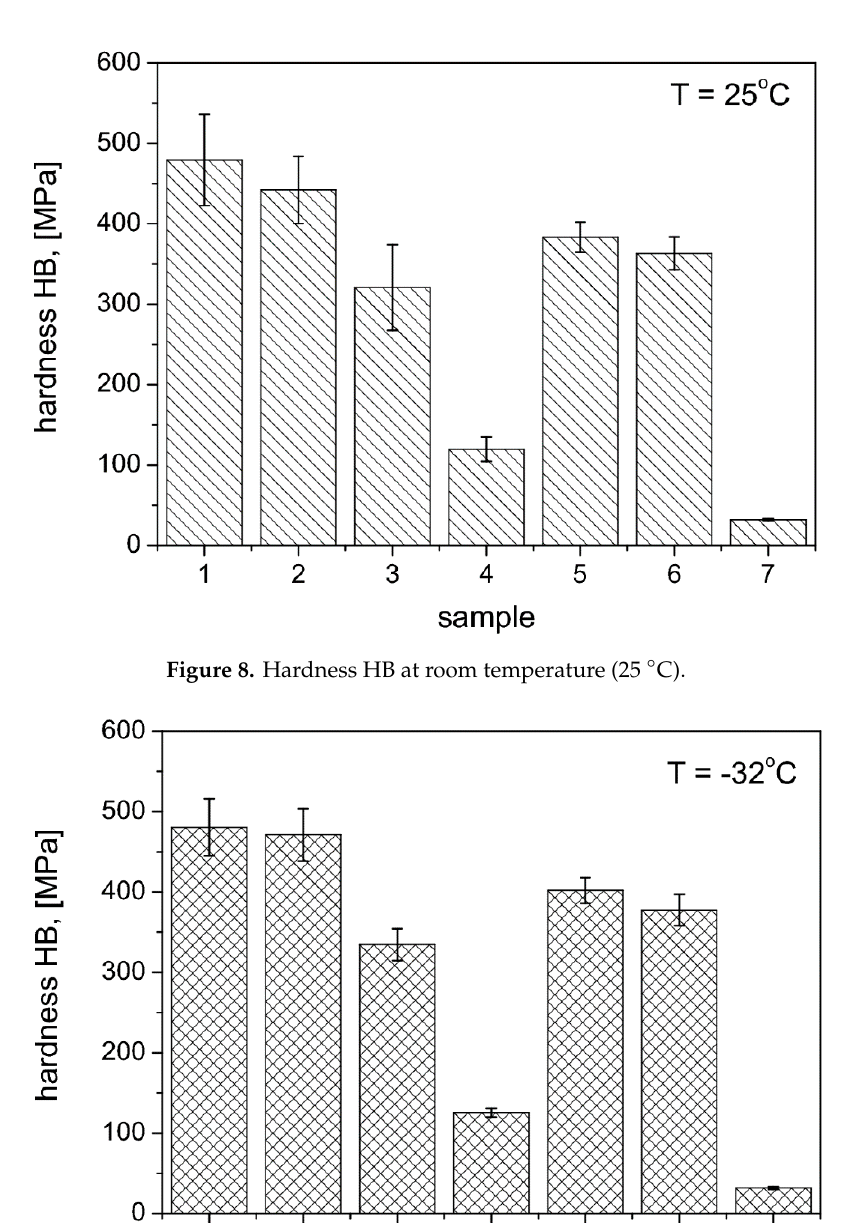
Figure 9. Hardness HB at temperature below zero Centigrade ( − 32 °C).